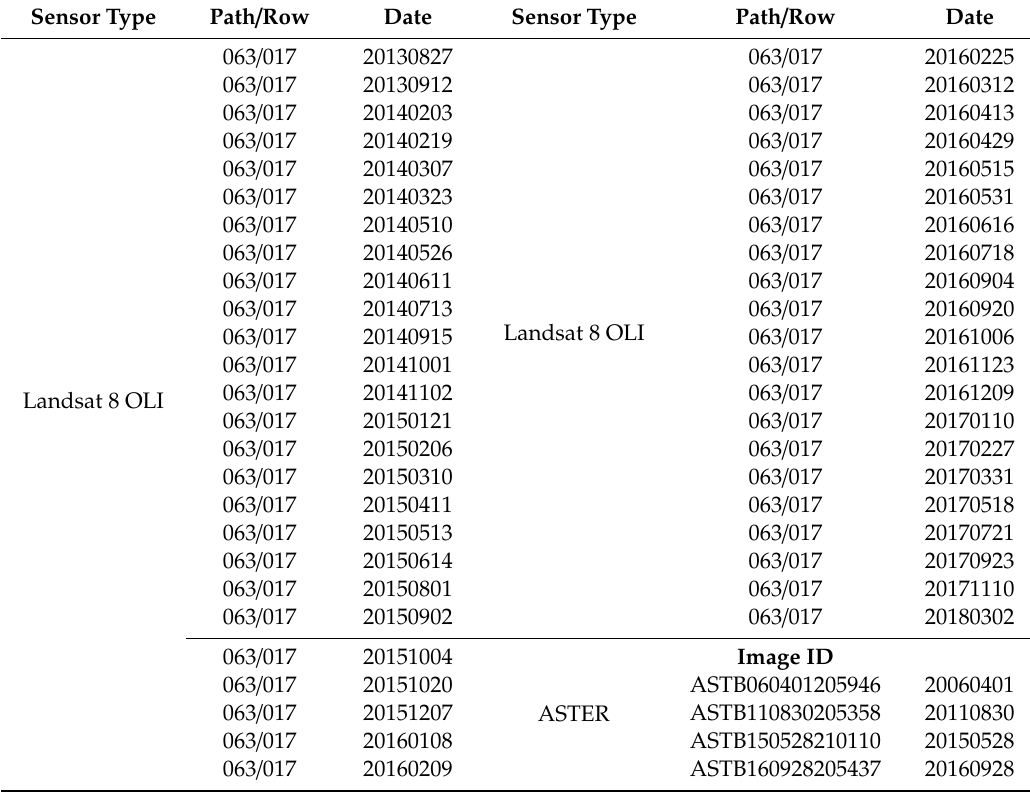
Table 1. Satellite image data used in this